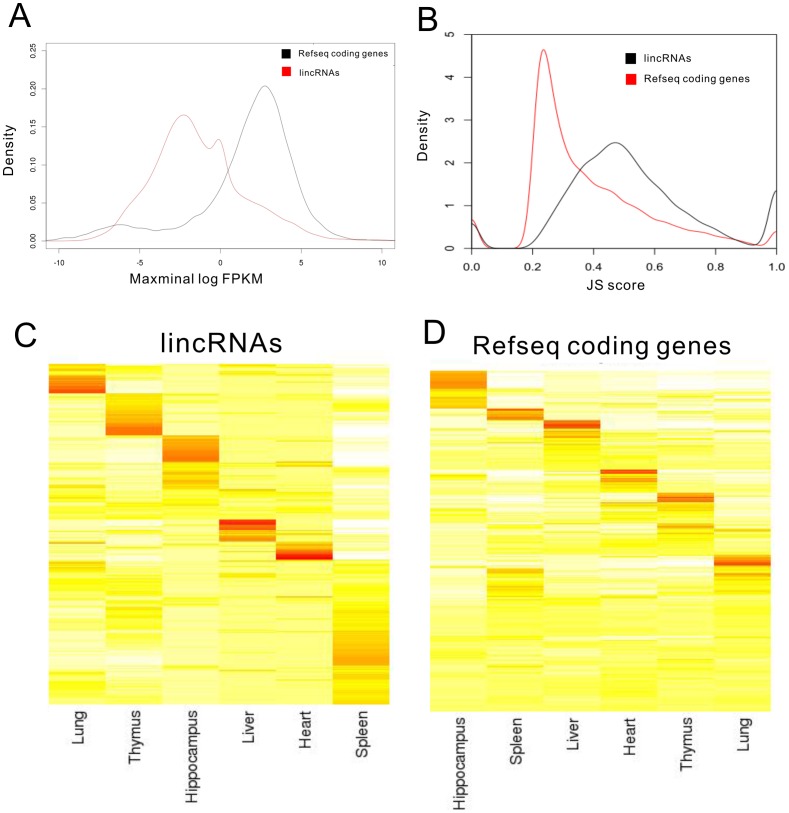
Tissue specificity of lincRNAs and protein-coding genes.(A) LincRNAs have lower expression levels than protein-coding genes. Maximal expression abundance (log2-normalized FPKM counts as estimated by Cufflinks) of each lincRNA (red) and coding (black) transcript across all tissues. (B) Tissue-specific expression. Shown are distributions of maximal tissue specificity scores calculated for each transcript across all tissues. (C) Cluster of the fractional density of lincRNAs across the row of log-normalized FPKM counts estimated by Cufflinks in each listed tissue. (D) Cluster of the fractional density of RefSeq protein-coding genes across the row of log-normalized FPKM counts estimated by Cufflinks in each listed tissue.